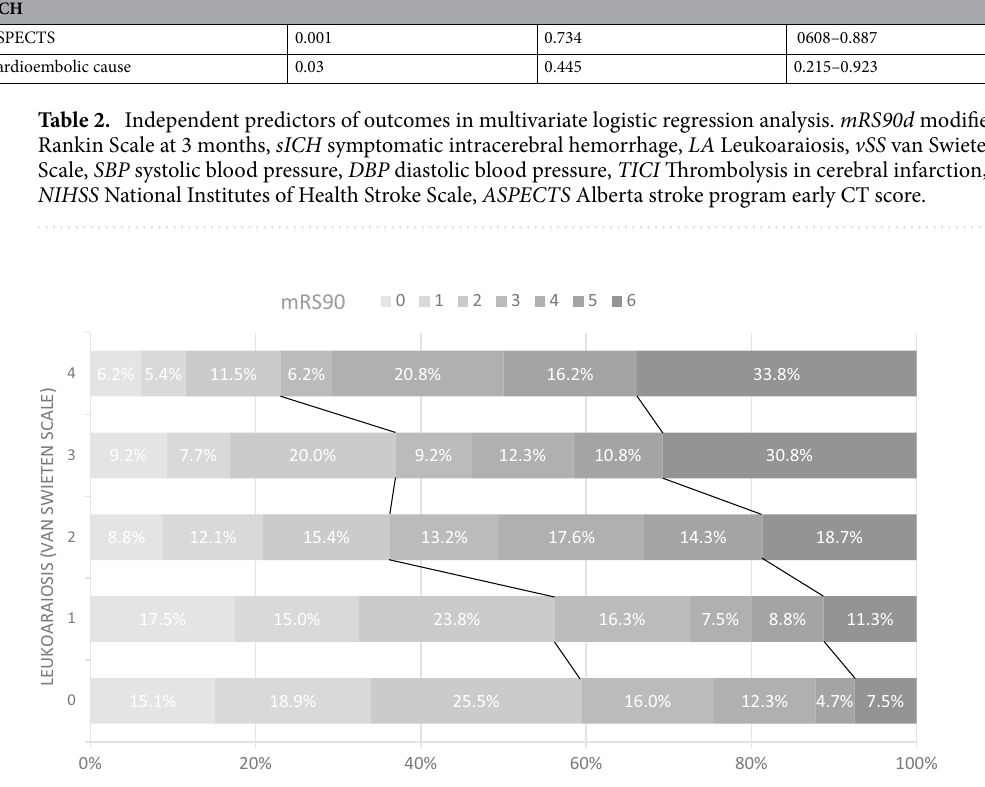
Figure 3. Clinical outcome in mRS90d depending on van Swieten Scale describing the degree of leukoaraiosis. mRS90d modified Rankin Scale at 3